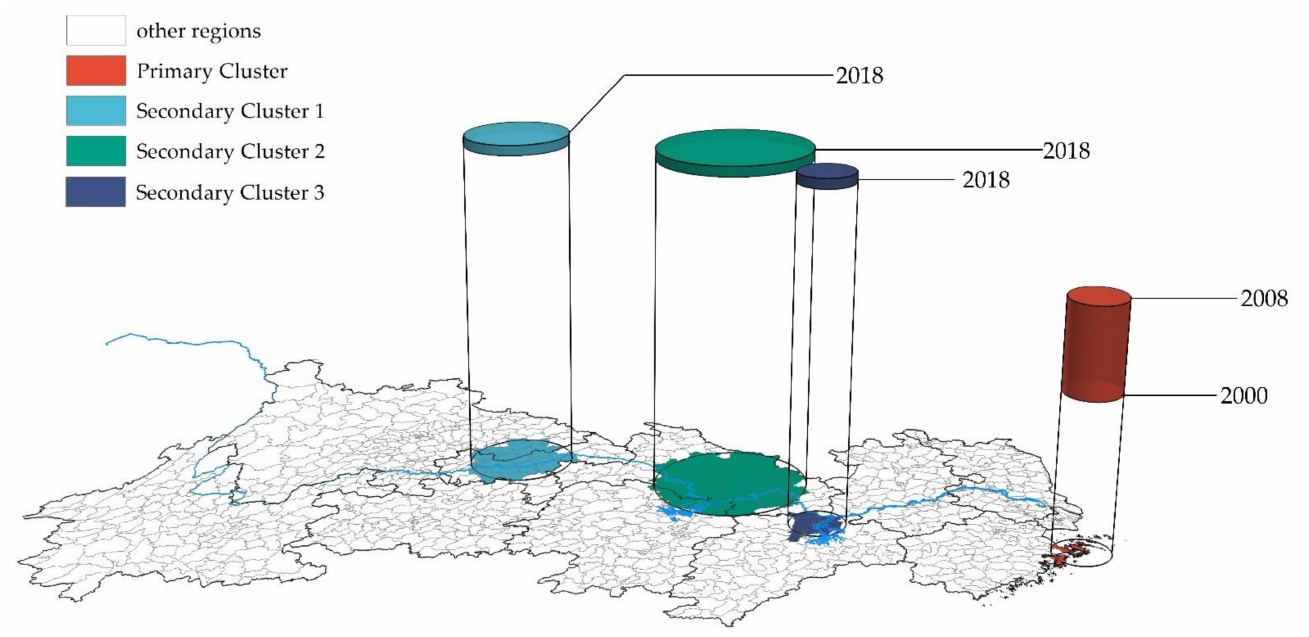
Figure 7. Spatiotemporal scanning results of PWD in the Yangtze River Basin